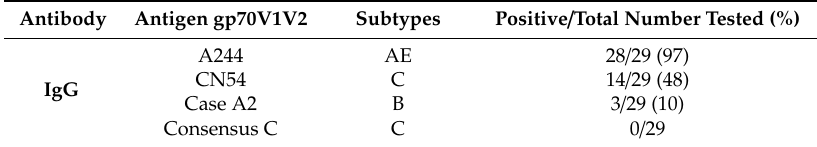
Table 1. Frequency of V1V2 IgG antibodies four weeks after the second HIV-MVA vaccination (HIVIS03